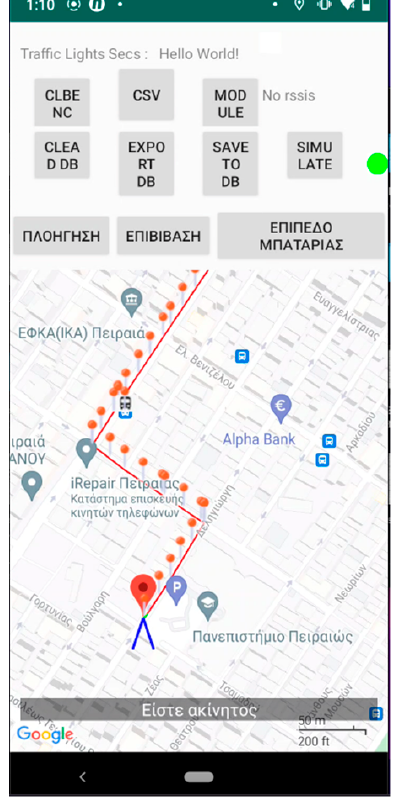
Figure 2. Application’s Training version—Main screen. It consists of three parts: the upper part con- tains the training app’s menu and the rest depicts the map, the user’s location and the navigational route. The Greek text on the last three buttons says, from left to right, “Navigation”, “Boarding”, and “Battery Level”.